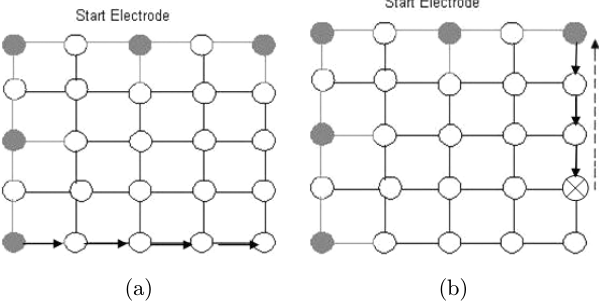
Fig. 8. Last electrode traversal in case of odd number of rows and columns in the microarray.